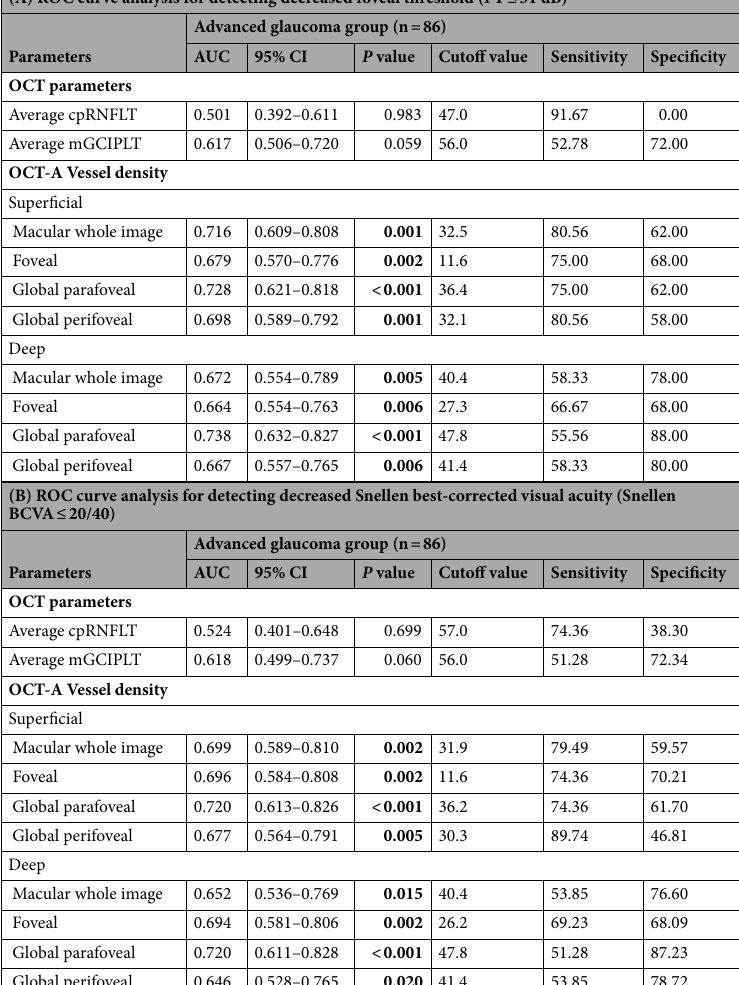
Table 3. The area under the receiver operating characteristic (ROC) curve analysis for optical coherence tomography (OCT) and OCT-angiography (OCT-A) parameters as predictors of decreased central visual function in advanced glaucoma patients. Statistically significant values are in bold. OCT, optical coherence tomography; OCT-A, optical coherence tomography angiography; FT, foveal threshold; AUC, area under the curve; CI, confidence interval; cpRNFLT, circumpapillary retinal nerve fiber layer thickness; mGCIPLT, macular ganglion cell-inner plexiform layer